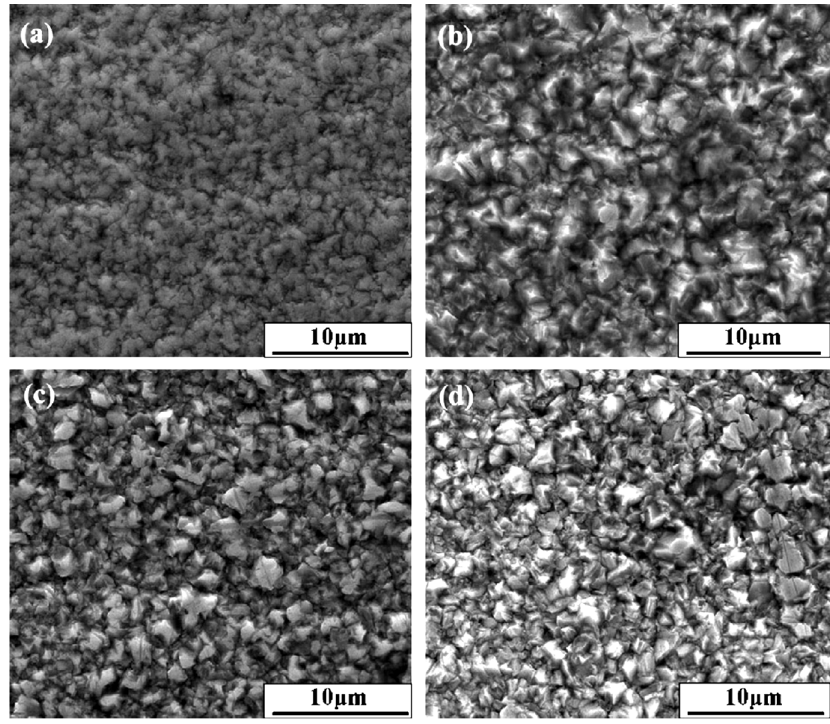
Figure 4. SEM observations of the surface micro-morphologies of Ni coatings obtained from a bath with 0 g/L ( a ), 0.1 g/L ( b ), 0.2 g/L ( c ), and 0.3 g/L ( d ) phytic acid. Reprinted with permission from [123]. Copyright 2010 Elsevier.